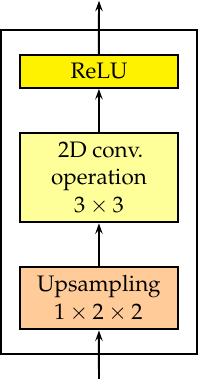
Figure 3. The detailed sturcture of a 2D De-convulutional layer